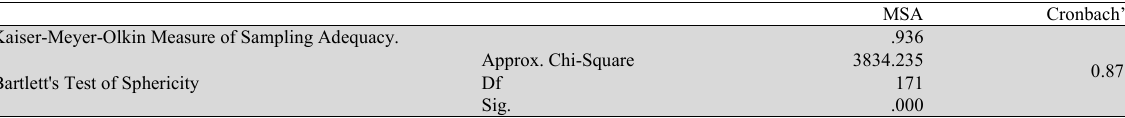
KMO and Bartlett's Test dan Cronbachs